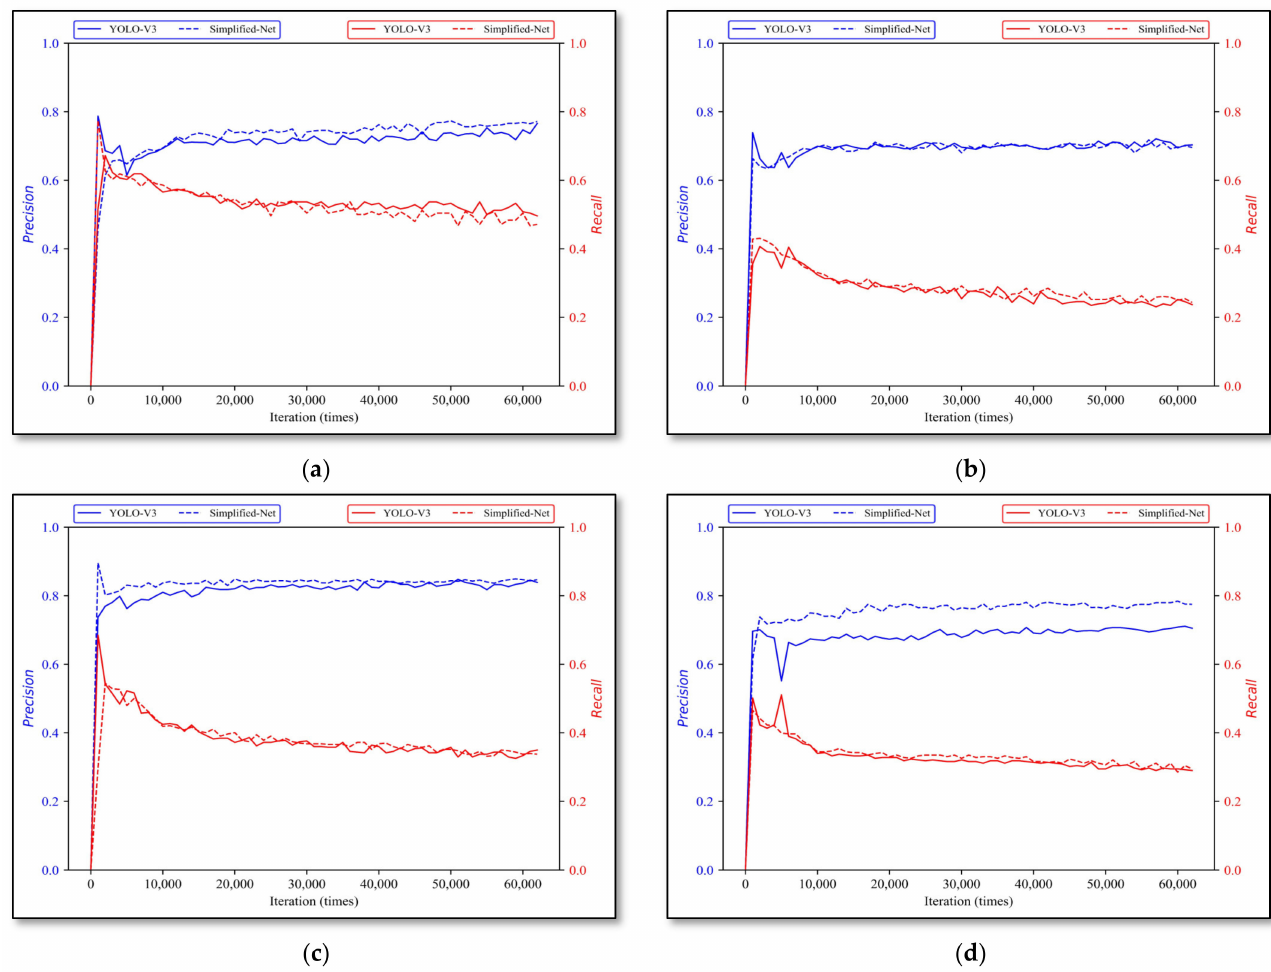
Figure 11. YOLO-V3 and Simplified-Net evaluation results. ( a ) monzogranite, ( b ) sandstone, ( c ) shale, and ( d )